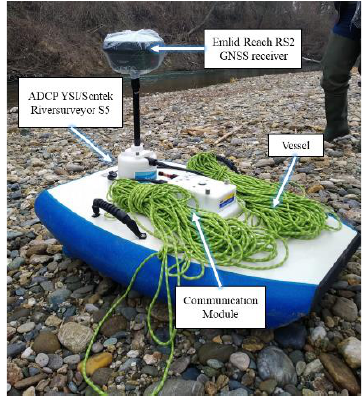
Figure 6. ADCP mounted on the mobile vessel.